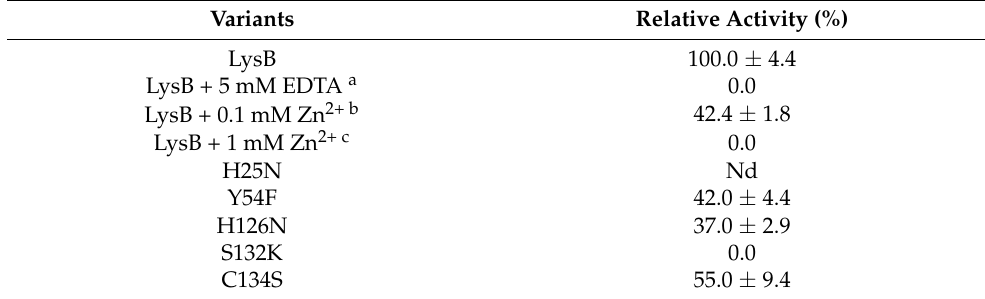
Table 1. Relative lytic activity of LysB variants. The activity was measured using turbidity reduction assay and C. sporogenes ATCC 7955 cells as a substrate. a Lytic activity of EDTA-treated LysB. b Lytic activity of EDTA-treated and -dialyzed LysB against chloroform-treated C. sporogenes ATCC 7955 cells supplemented with Zn 2+ metal ions at 0.1 mM concentration. c The reaction conditions were the same as in sample b , but Zn 2+ was supplemented to 1 mM concentration. Nd—the activity of variant H25N was not determined because it remained insoluble during purification. Variants Relative Activity (%) LysB 100.0 ±